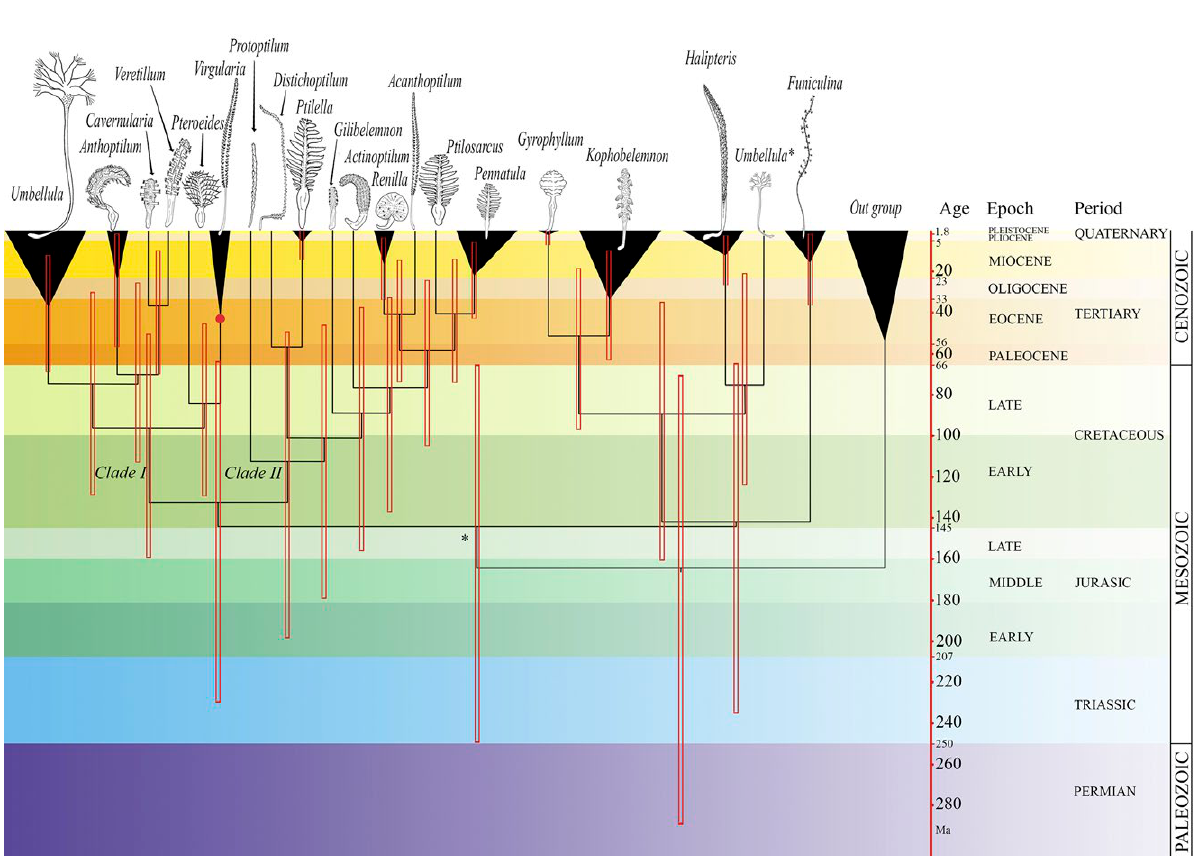
Fig. 2. – Calibrated tree from Time Divergence Analysis (based on mtMutS + Cox1 + 28S ) showing the divergence among genera, and the diverse pennatulacean colonial morphologies. Red dot indicates fossil calibration point. The confidence intervals of the divergence age estimates are indicated at each